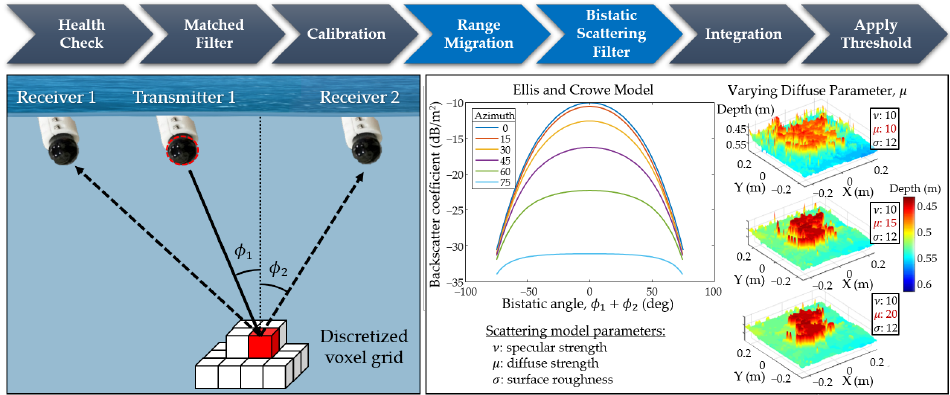
Figure 6. Illustrations of ray tracing in range migration, and the effect of varying the diffuse parameter ( µ ) in Ellis and Crowe bistatic scattering filter